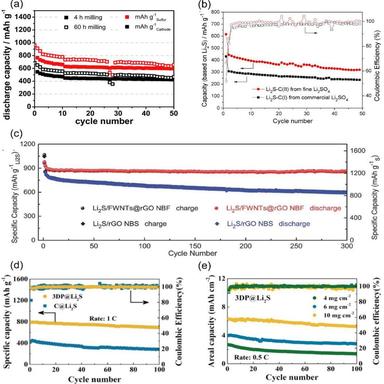
(a) The specific capacity over cycle number at 0.1C for Li2S-C cathodes by 4-h and 60-h ball-milling pre-treatments. (b) The cycling stability of Li2S-C by carbon coating at 0.2C . (c) The cycling stability of the Li2S/FWNTs@rGO NBF cathodes at 0.2C. (d) The cycling stability of Li2S-C via 3D printing at 1C. (e) The areal capacity of Li2S-C via 3D printing at 4, 6 and 8 mg Li2S=cm2 at 0.5C. Reproduced from Refs. with permission from Wiley